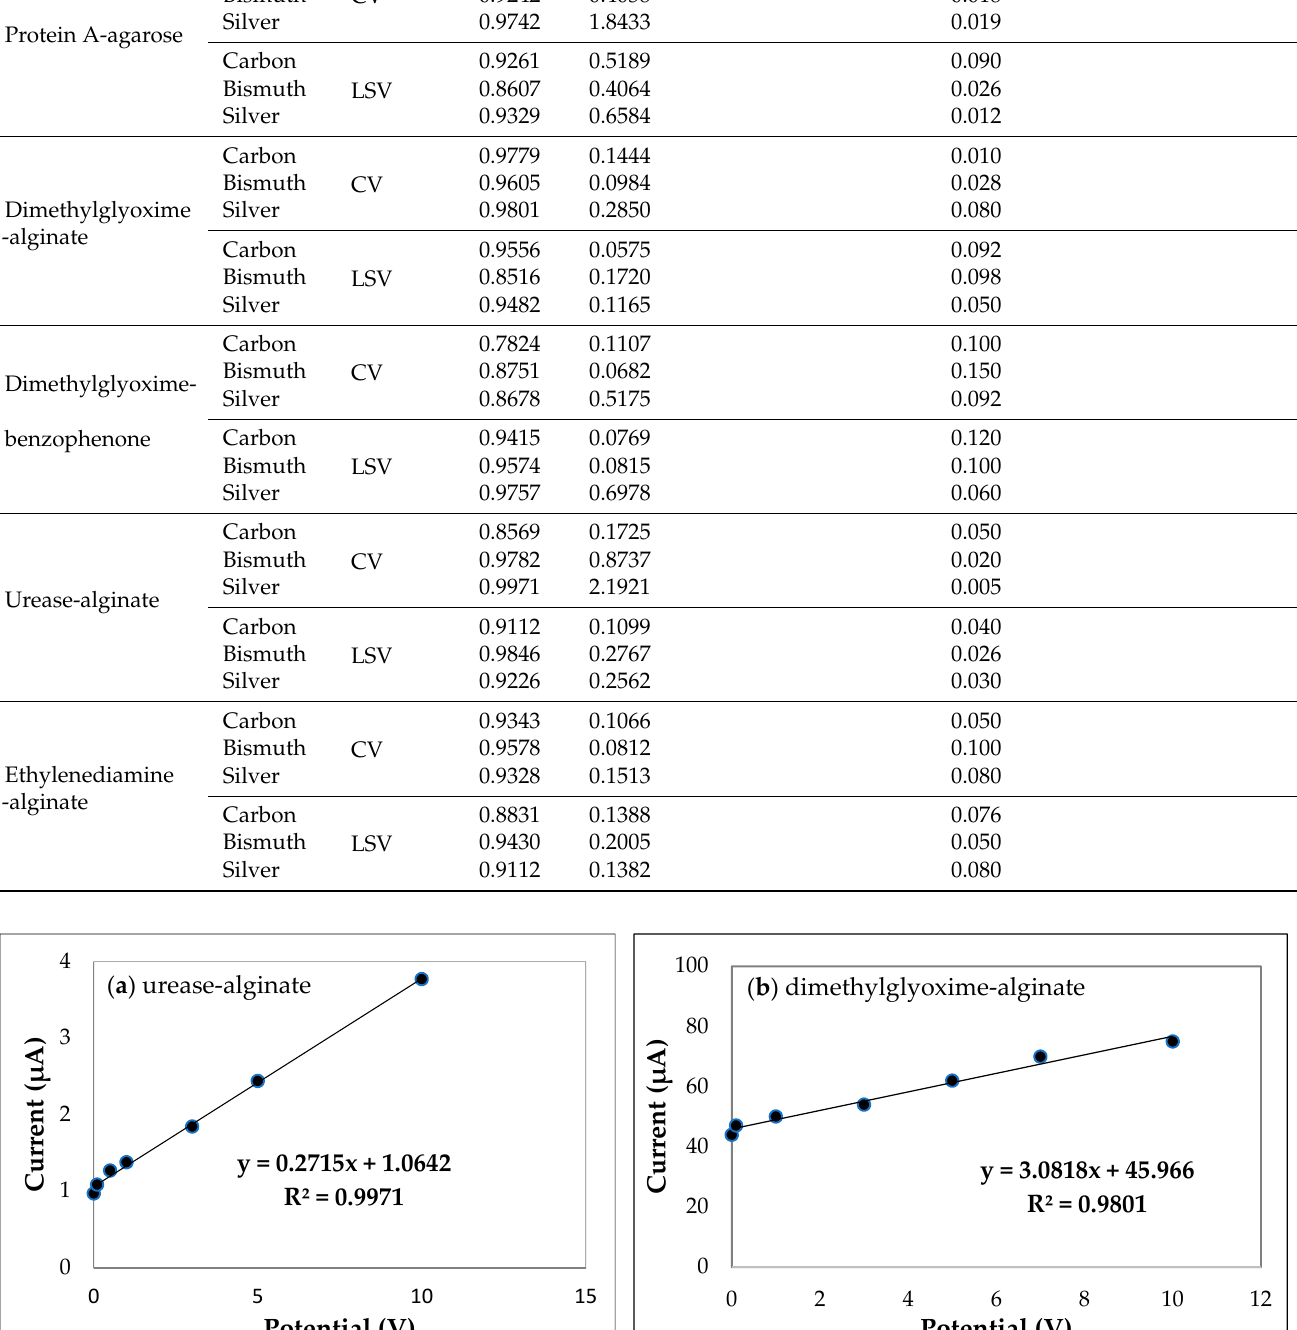
y = 0.2715x + 1.0642 R² = 0.9971